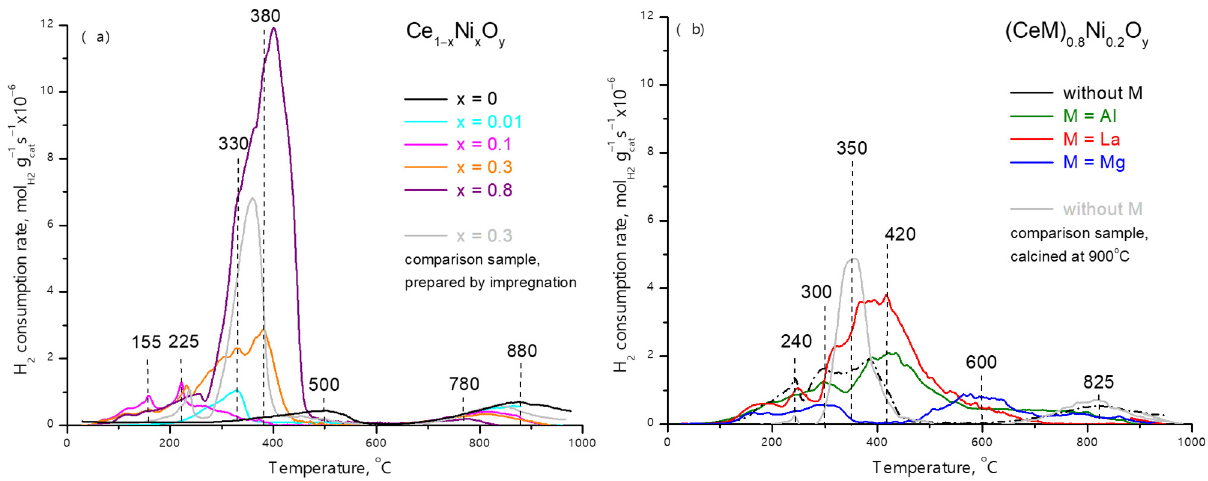
Figure 10. H 2 -TPR profiles of (CeM) 1 − x Ni x O y (M = Al, La, Mg) samples: effect of Ni molar fraction ( a ) and M type ( b ). ( b )—M/Ce molar ratio is equal to 1.